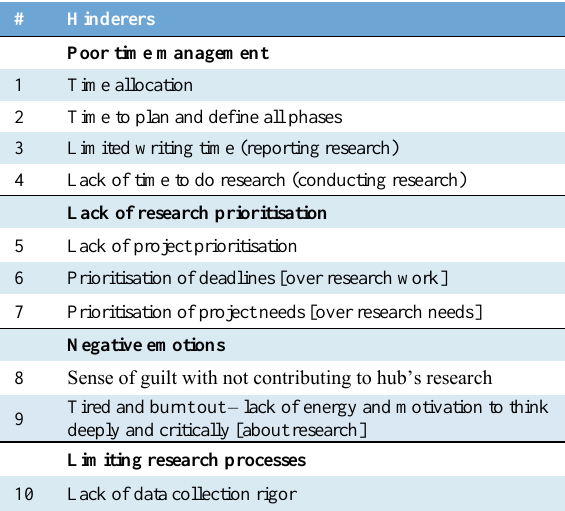
Table 3. Research process and production hinderers.